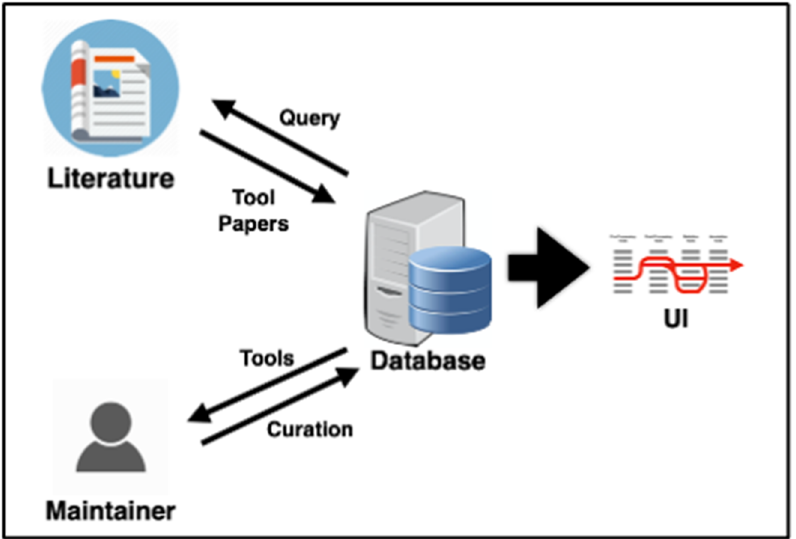
Figure 1. Schematic of MSCAT function. A semi-automated process is implemented where the database server periodically queries the literature and extracts new published tools to be displayed in the user interface (UI). The tools classification is then curated by the database maintainer.